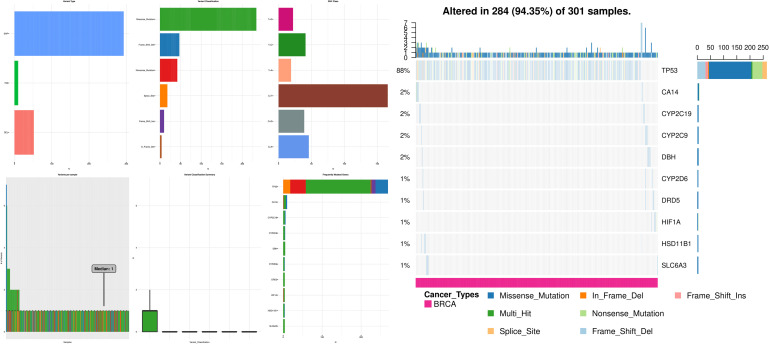
Illustrations here represent that missense mutations and truncating mutations mediate gene signaling in the case of TNBC, where the first panel depicts the variant type, the second panel depicts the variant per sample, the third panel depicts the variant classification, the fourth panel depicts the variant classification summary, the fifth panel depicts the SNV class, the sixth panel depicts the frequently mutated genes and the seventh panel depicts the CNA events occurred in the cell cycle control.